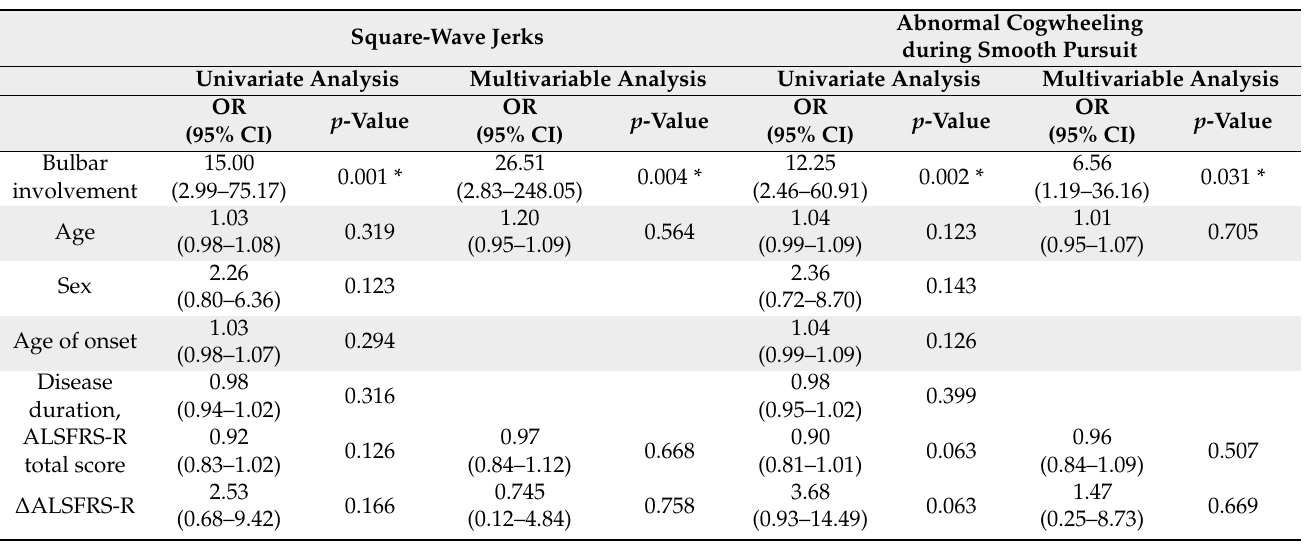
Table 5. Univariate and multivariate logistic regression analyses between clinical data and oculomotor performance of ALS patients with and without bulbar